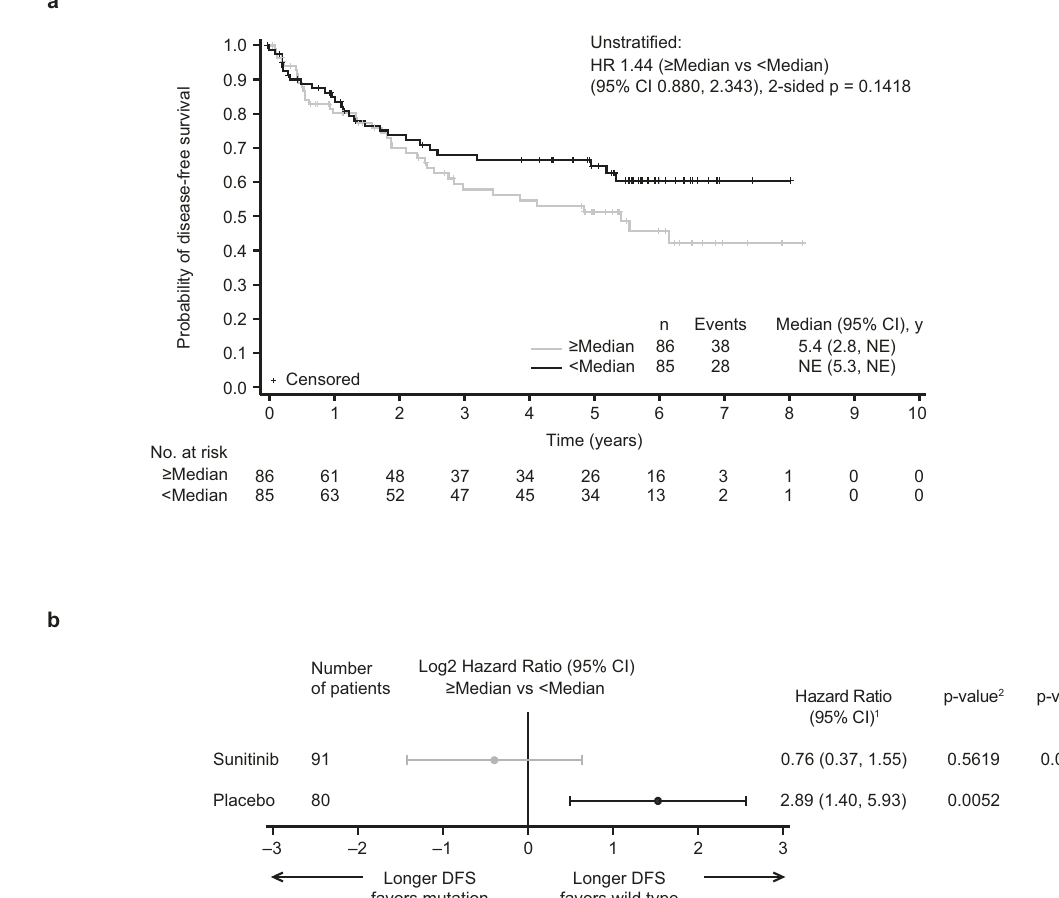
Fig. 2 | DFS association with TMB. a Kaplan – Meier plot for TMB in the overall cohortand b treatmentarmeffectofTMBandDFSassociationstrati fi edbymedian cutoff.DataarepresentedasHRand95%CI. 1 Coxproportionalhazardsmodelwith <Median as the reference group was used to calculate HR and 95% CI. 2 Log-rank two-sidedtestwasperformedtocomparebetweenoverallmediancutoffgroups.A HR<1indicatesbettersurvivalinthe ≥ Mediangroup,whileaHR>1indicatesbetter